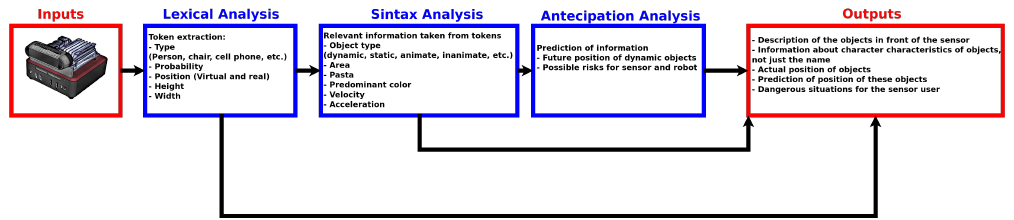
Figure 2. An overview of Semantic Description and Dynamic Interaction (SD2I) methodology.